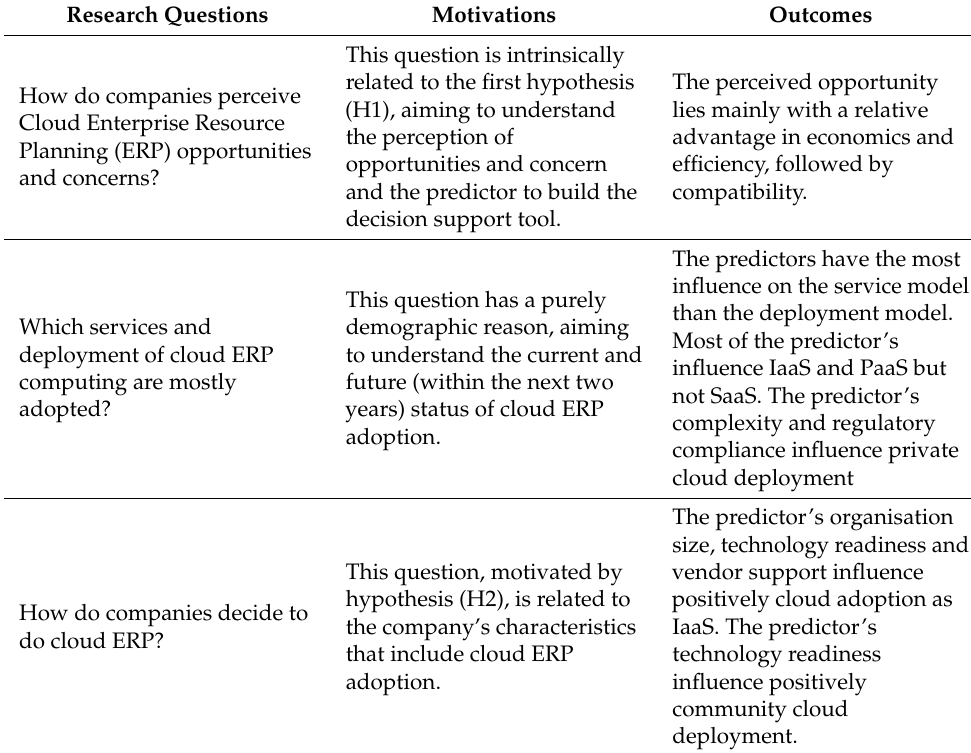
Table 1. Research questions, motivations and